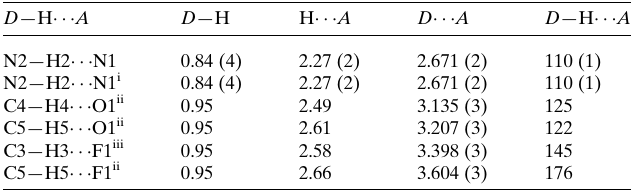
Table 2 Hydrogen-bond geometry (A˚ , (cid:2) ) for 2 .